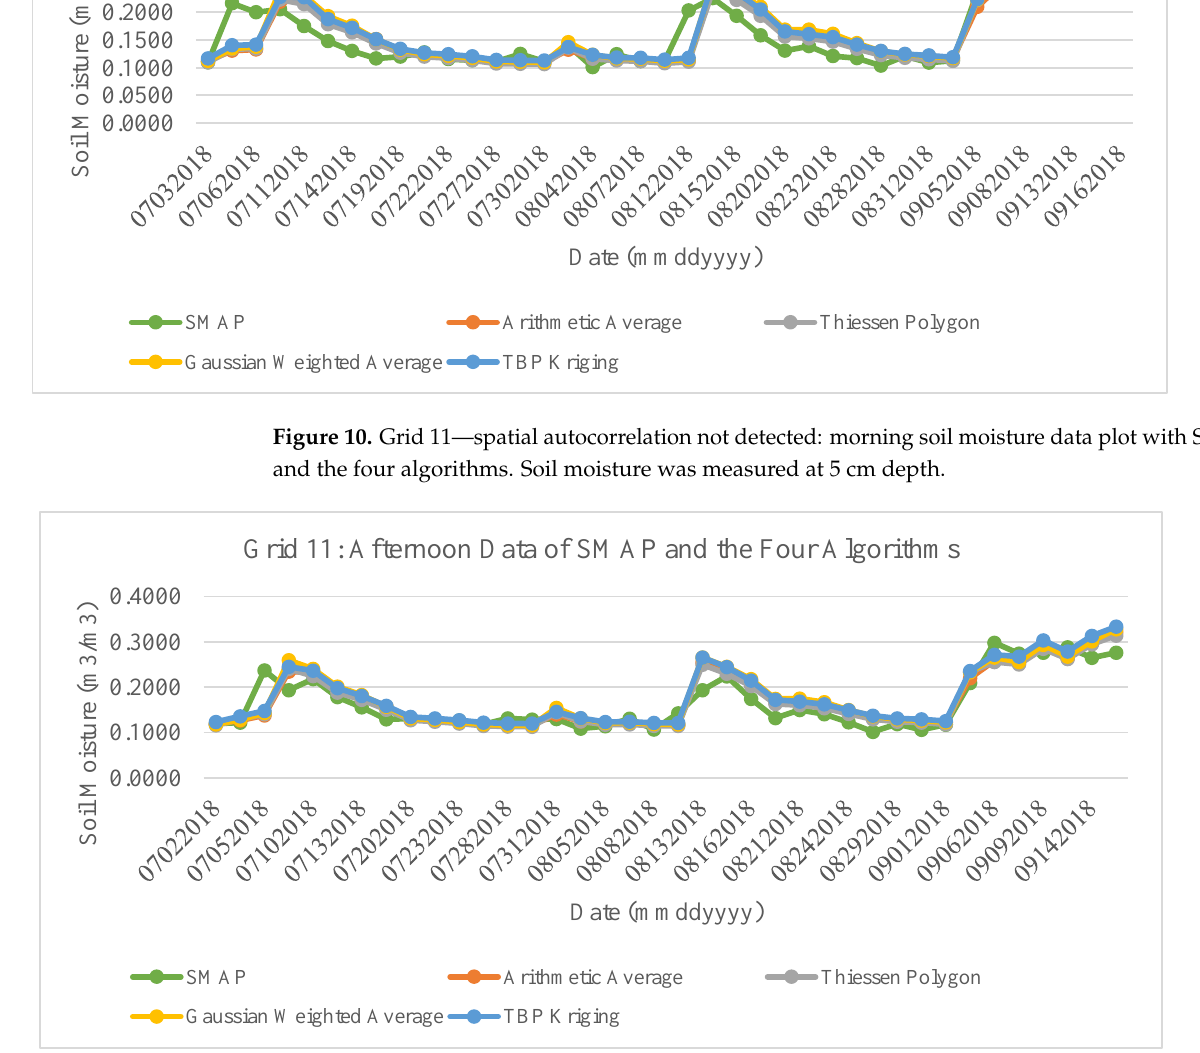
Figure 11. Grid 11 — spatial autocorrelation not detected: afternoon soil moisture data plot with SMAP and the four algorithms. Soil moisture was measured at 5 cm depth.